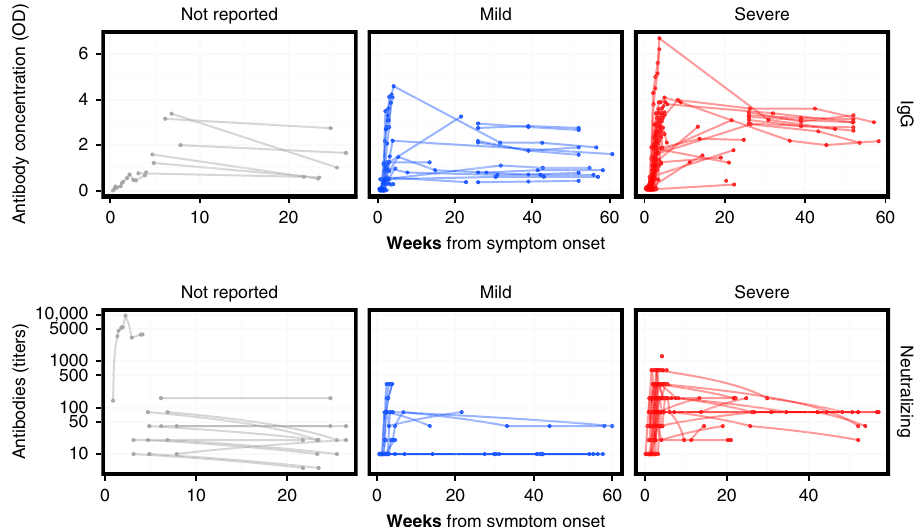
Fig. 3 MERS-CoV antibody kinetics. The top row shows the data for studies reporting IgG concentration in units of optical density, while the bottom row shows the data for studies reporting neutralizing antibodies in units of titers. The columns correspond to different severity categories. Each line corresponds to time series for an individual patient. Some studies reported titers that were lower than or greater than some threshold value; those are here plotted at those values (e.g., for ≥ 320, the value is assumed to be 320). Some studies may report the kinetics of different antibodies or using different assays (and different units) for the same patient. Note that while these are plotted on the same axis, values may not necessarily be comparable across studies within each panel, as each lab may have different assay conditions resulting in different scales. See Supplementary Figs. 3 and 4 for (more limited) the data on SARS-CoV and IgA. Colors re fl ect the severity categories: not reported (gray), mild (blue), and severe